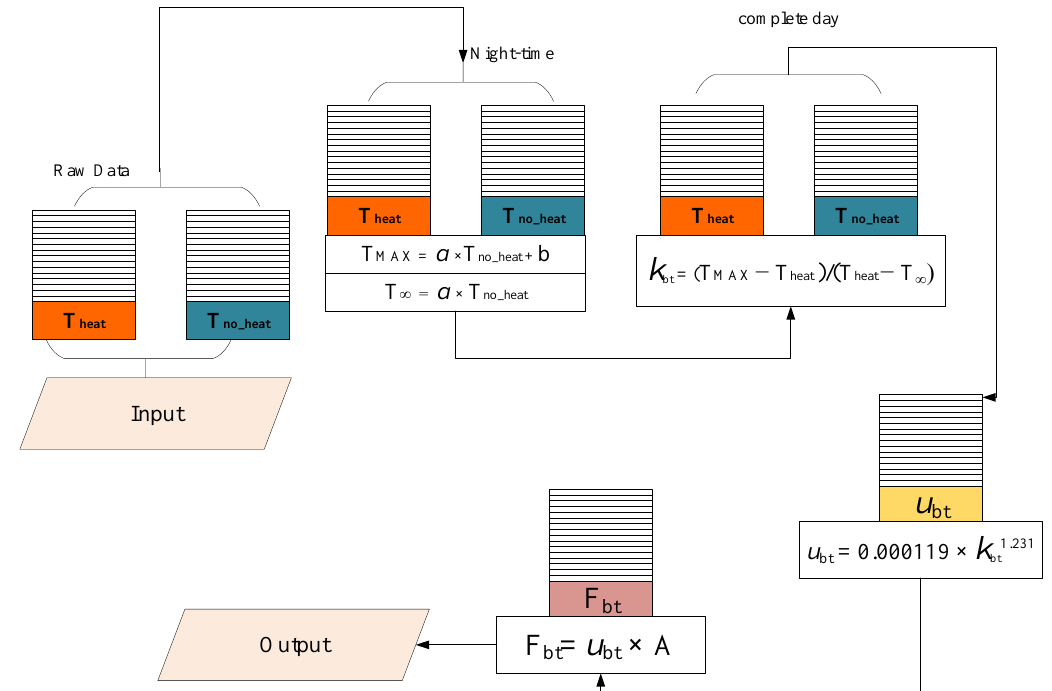
Figure 1. Transpiration computation flow. T heat (local heated sap temperature); T no − heat (local unheated sap temperature); T MAX (maximum sap temperature); T ∞ (environment temperature); k bt (Biot-Granier sap flow index); u bt (Biot-Granier sap flow density); Fbt (transpiration with Biot-Granier approach).